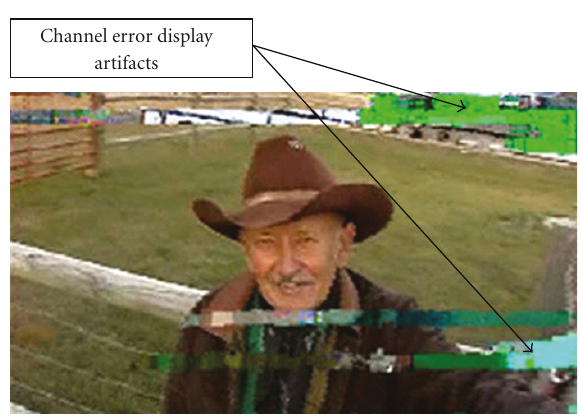
Figure 4: Displayed e ff ects of DTV channel